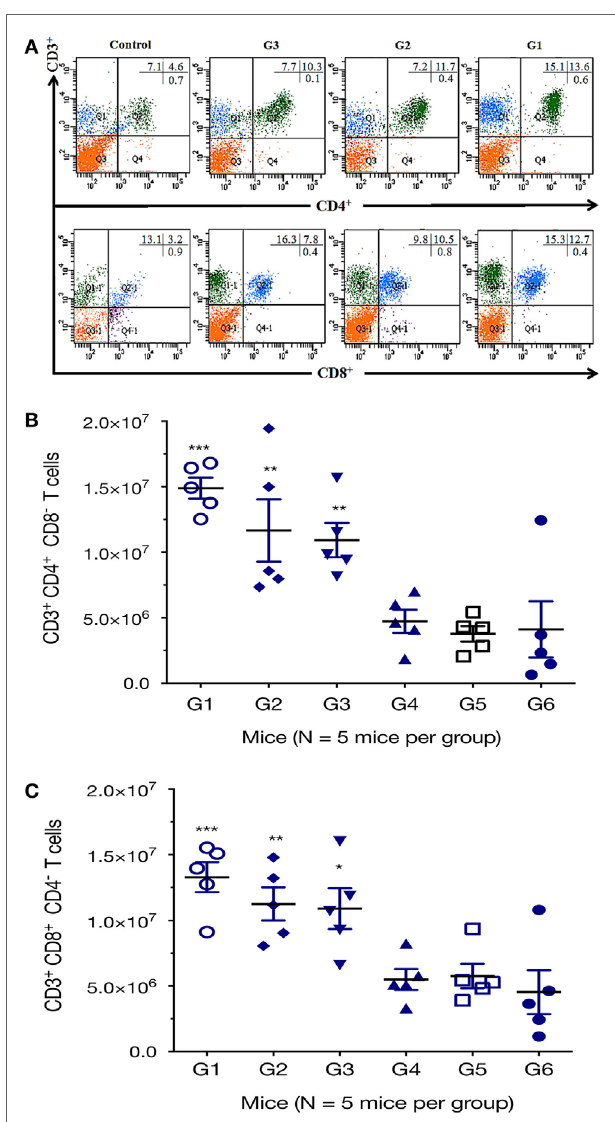
FigUre 4 | DNA immunization augmented the frequency of antigen-specific T cells. Percentages of CD4 + and CD8 + T cells subsets were determined in the spleen of mice 2 weeks after the final immunization by flow cytometry analysis. (a) Representative dot plots showing the percentages of CD3 + CD4 + CD8 − and CD3 + CD8 + CD4 − T lymphocytes. (B) Total numbers of CD3 + CD4 + CD8 − T lymphocytes per spleen. (c) Total numbers of CD3 + CD8 + CD4 − T lymphocytes per spleen. Experimental groups include G1: mice received pVAX1 plasmids containing five antigens (ROP16, ROP18, MIC6, CDPK3, and PF); G2: mice received pVAX1 plasmids containing four antigens (ROP16, ROP18, MIC6, and CDPK3); G3: mice received pVAX1-PF;